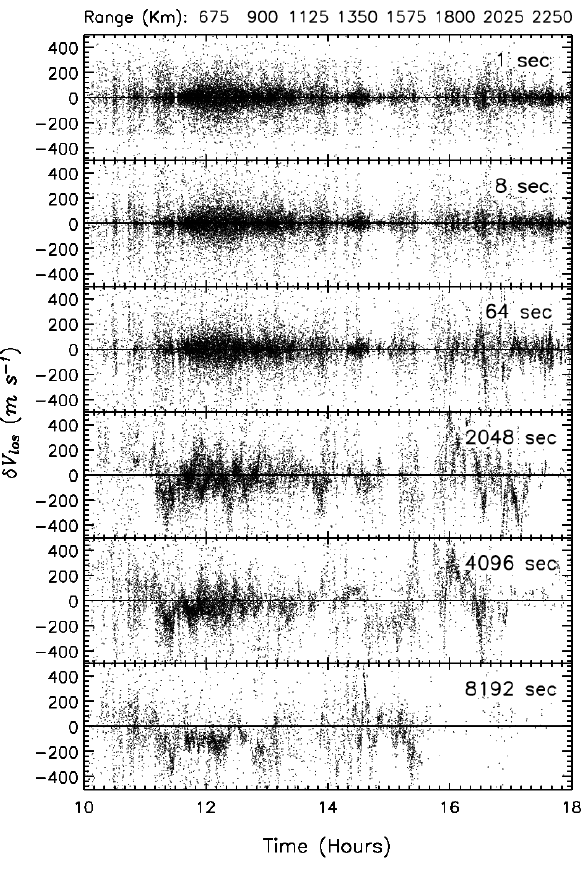
Fig. 2. Magnetic clock dial plots showing the number of valid echoes detected on magnetic meridian pointing beam 4 of the Tas- manian radar. The results have been split into (a) Population B and (b) Population A echoes with spectral width < 75ms − 1 and > 150ms − 1 , respectively (FITACF version 1.22). Bin sizes of 2h of magnetic local time (MLT) and 45km of group delay were used. Beam 12 of the New Zealand radar points toward the south west and the corresponding results are not well represented in this format.